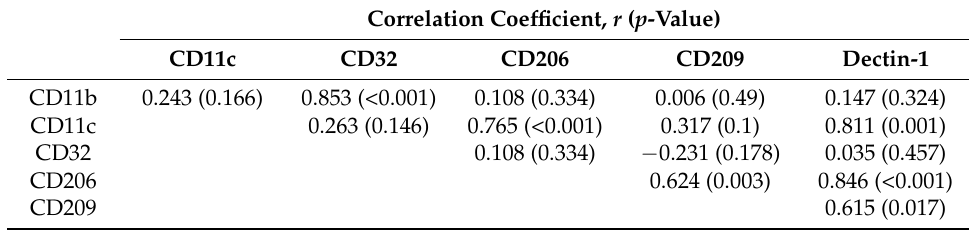
Table 3. Correlations between each cell surface marker in patients with adult-onset Still’s